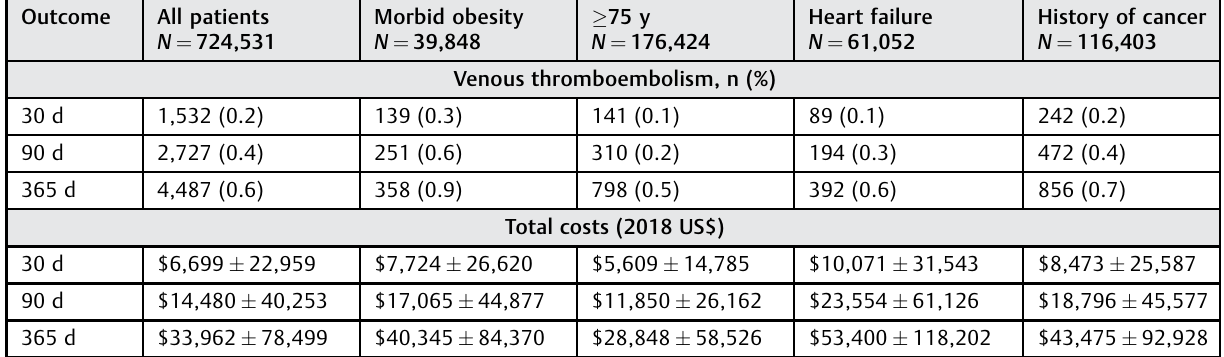
Table 2 Post-index hospitalization outcomes in subsets of patients with > 5% prevalence of an additional risk factor for venous thromboembolism Outcome All patients N ¼